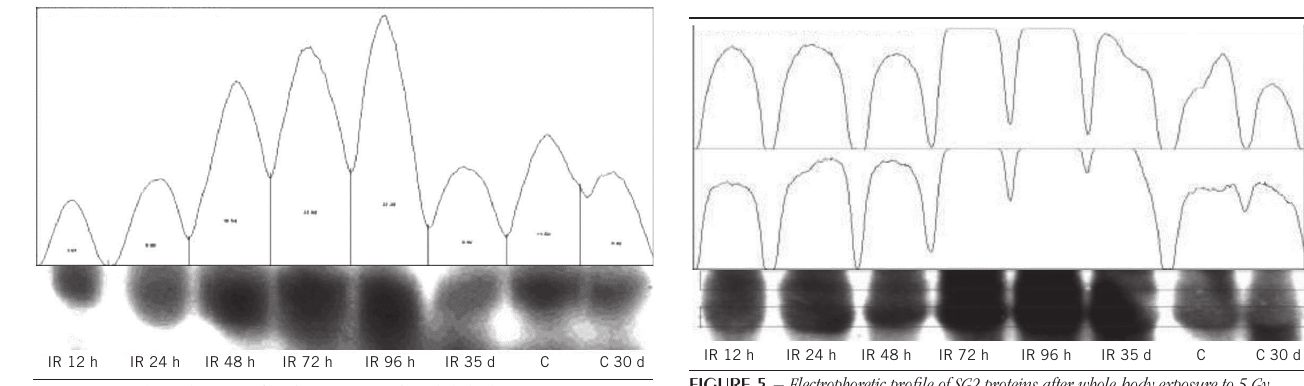
figurE 3 − Electrophoretic profile of SG4 proteins after whole-body exposure to 5 Gy SG4: subgroup 4.